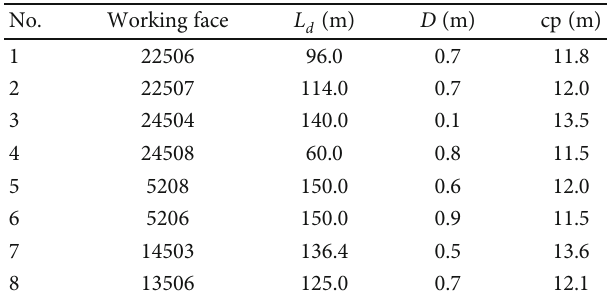
Table 4: The depth of fl oor failure and main control factors in the study area.